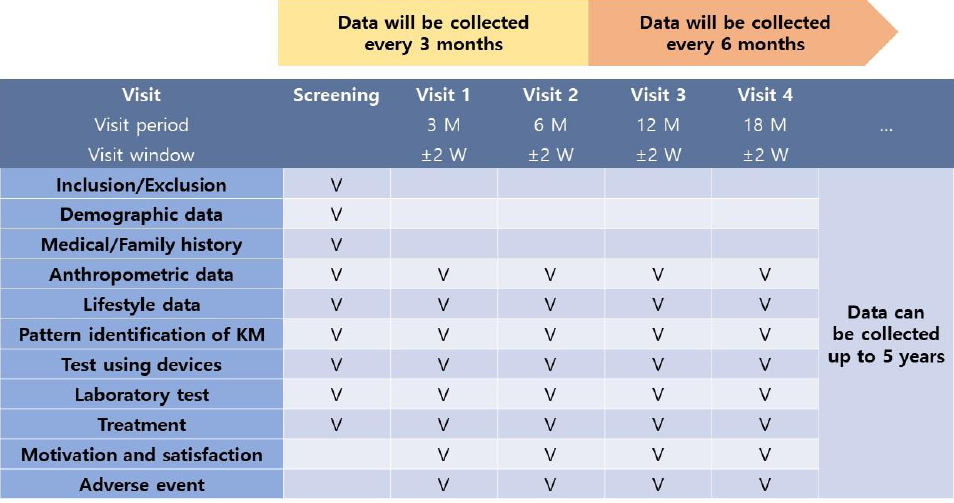
Figure 1. Study flowchart. KM, Korean